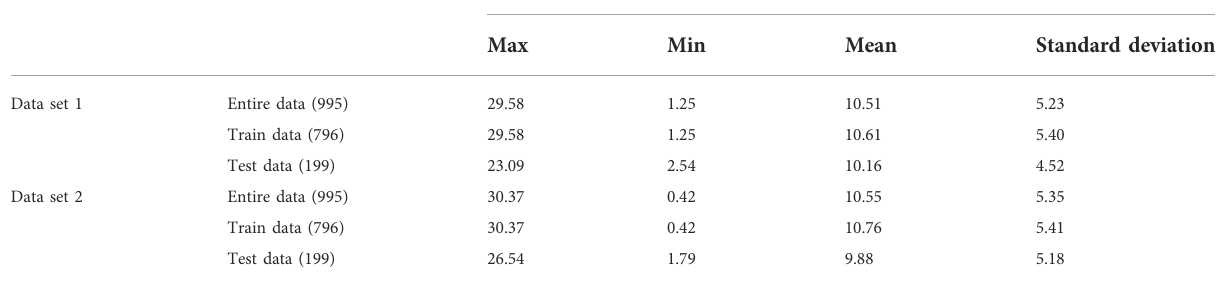
TABLE 2 The statistical information of two data sets.